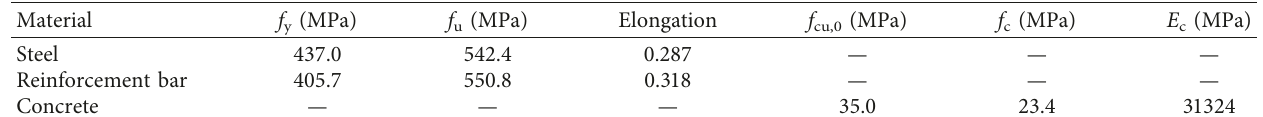
Table 1: Material